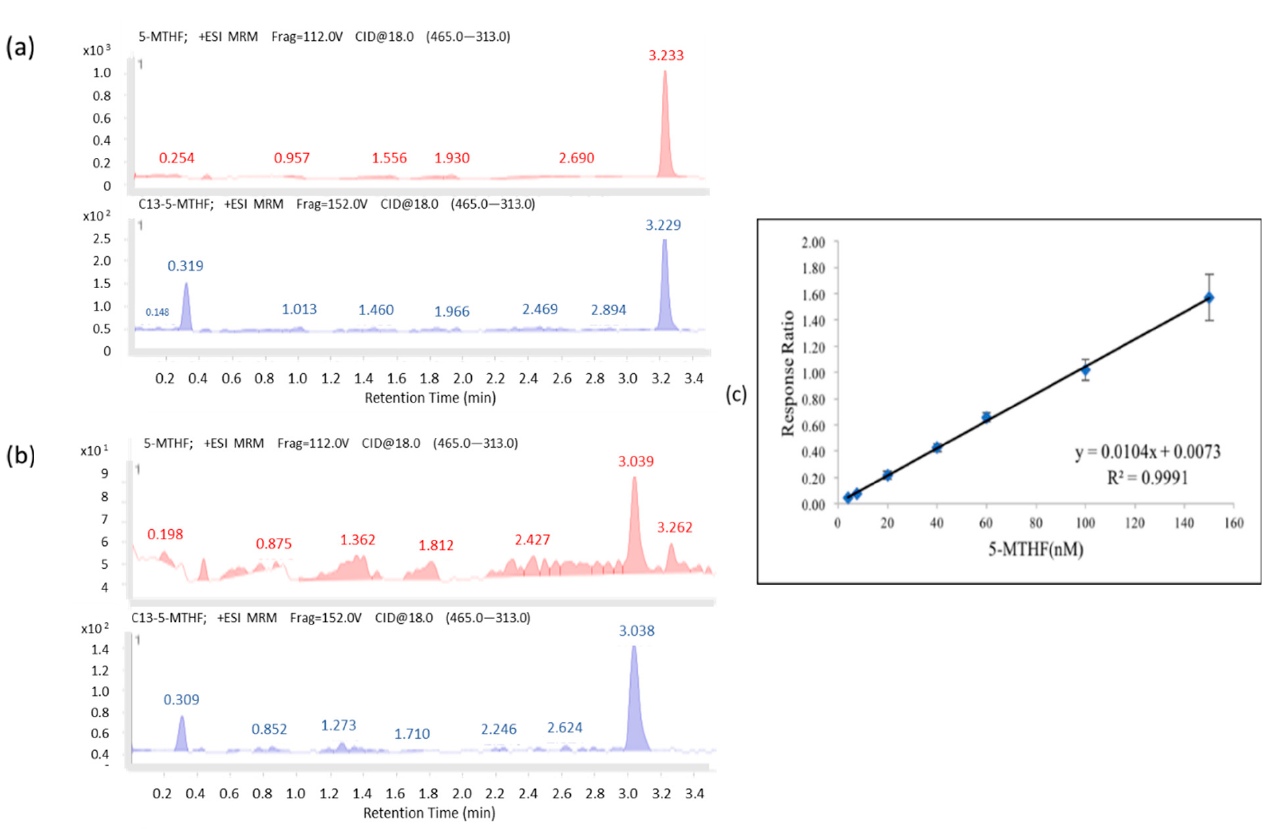
Figure 1. Chromatograms of 5-MTHF: ( a ) the standard (in pink; 40 nM 5-MTHF; retention time 3.233 min) and its spiked internal standard (in blue; 13 C5-MTHF 96 nM; retention time 3.229 min)